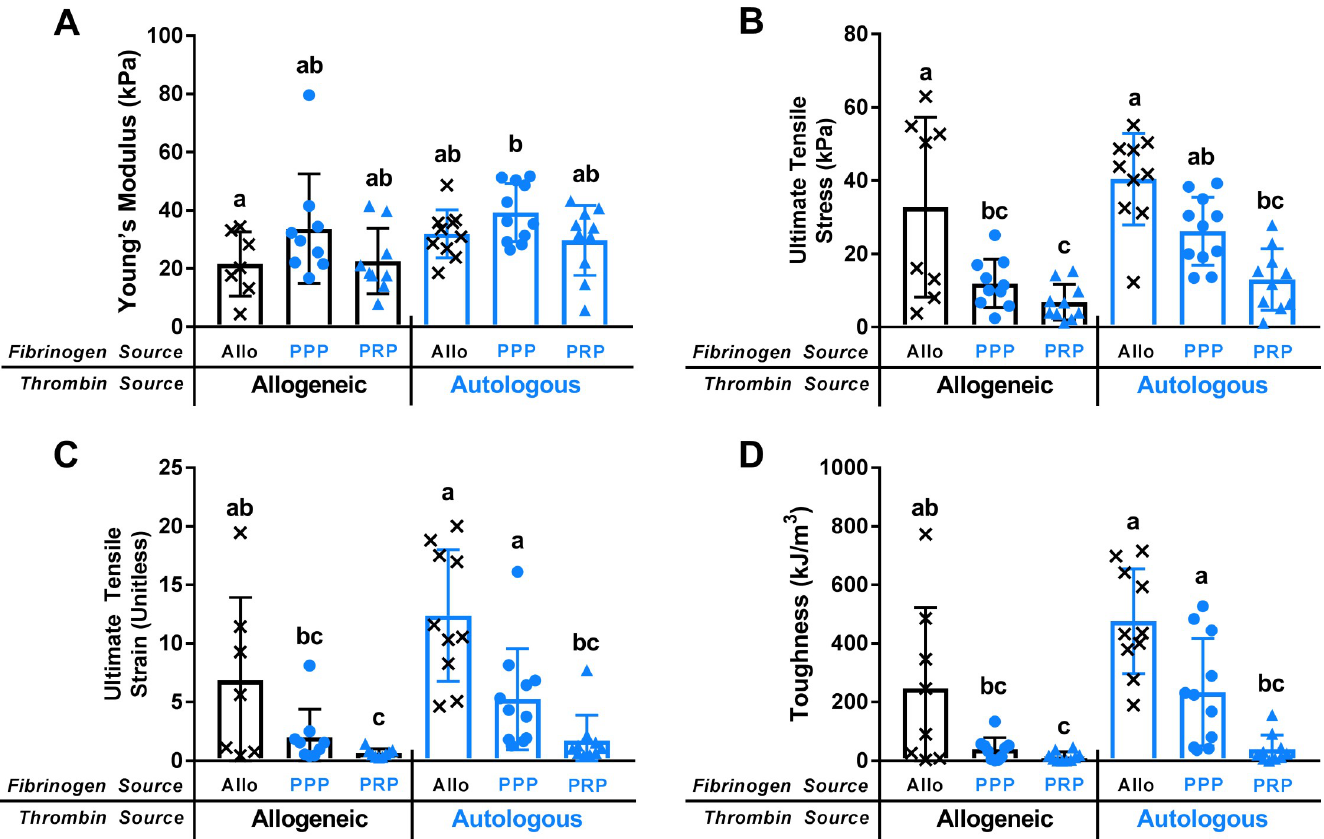
Fig 4. Young’s Modulus and failure properties of fibrin sealants. Young’s Modulus (A) and failure outcomes of ultimate tensile stress (B), ultimate tensile strain (unitless) (C), and toughness (D) for fibrin sealants. Thrombin source denoted by bar outline color (allogeneic: black; autologous: blue) and fibrinogen source by data point color and shape (x: allogeneic; circle: PPP; triangle: PRP). Fibrinogen sources on x-axis. Sealants with different letters were statistically significant.